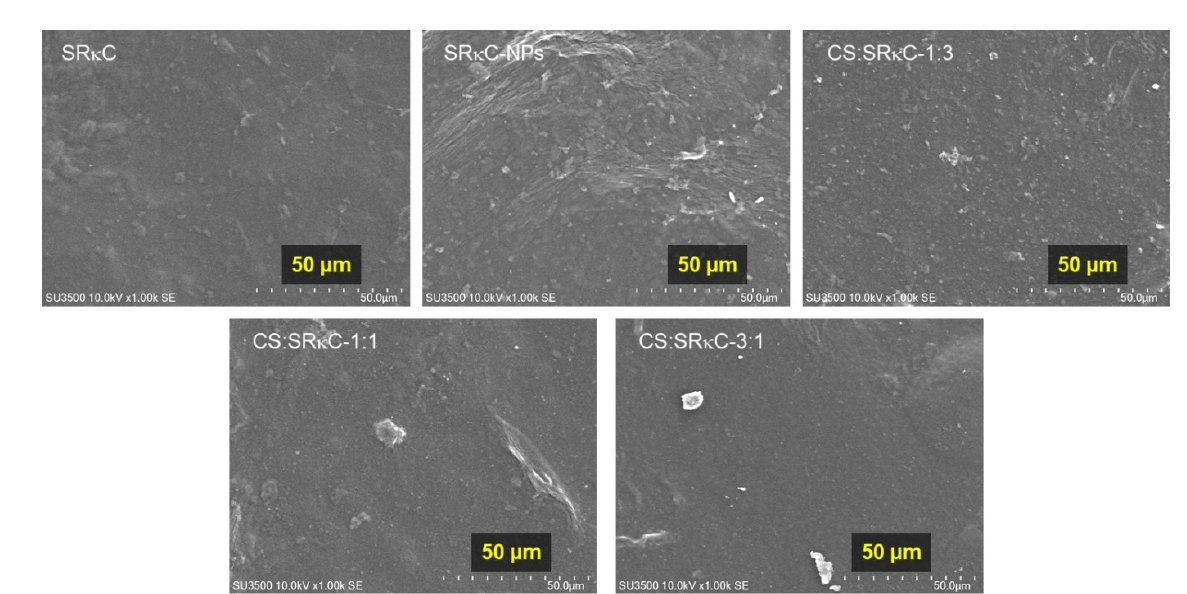
Figure 4. SEM images of SR κ C films at various CS concentrations.